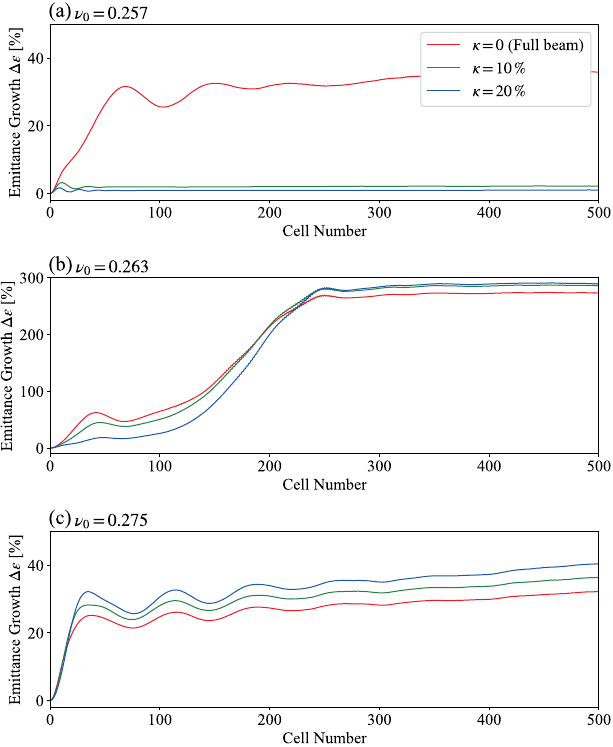
FIG. 7. Time evolution of the rms emittance-growth rates in the three cases of Figs. 4 – 6. The operating bare tune per cell is fixed at (a) ν 0 ¼ 0 . 257 , (b) ν 0 ¼ 0 . 263 , and (c) ν 0 ¼ 0 . 275 .